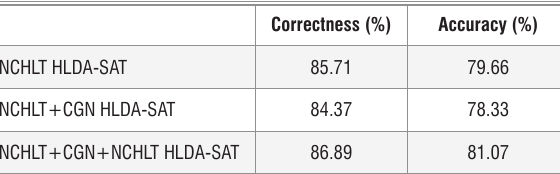
Correctness and accuracy results for heteroscedastic linear discriminant analysis (HLDA)- and speaker adaptive training (SAT)-based data sharing automatic speech